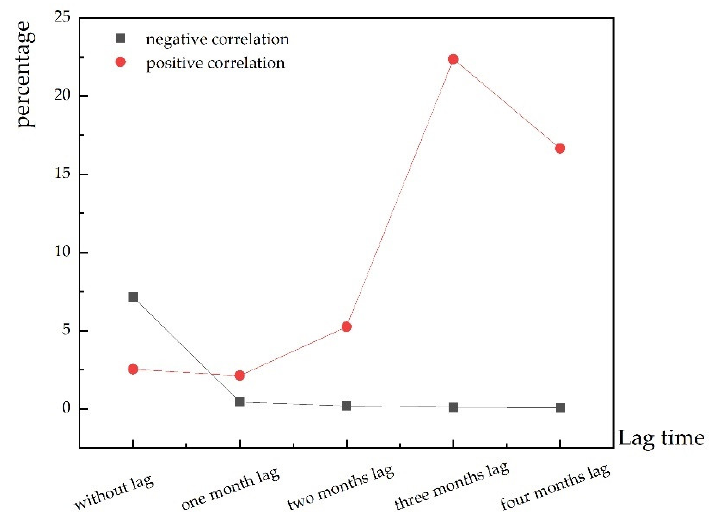
Figure 11. Analysis of the proportions of pixel values of ≤−0.5 (negative correlation) and pixel values of ≥0.5 (positive correlation) under different lags.